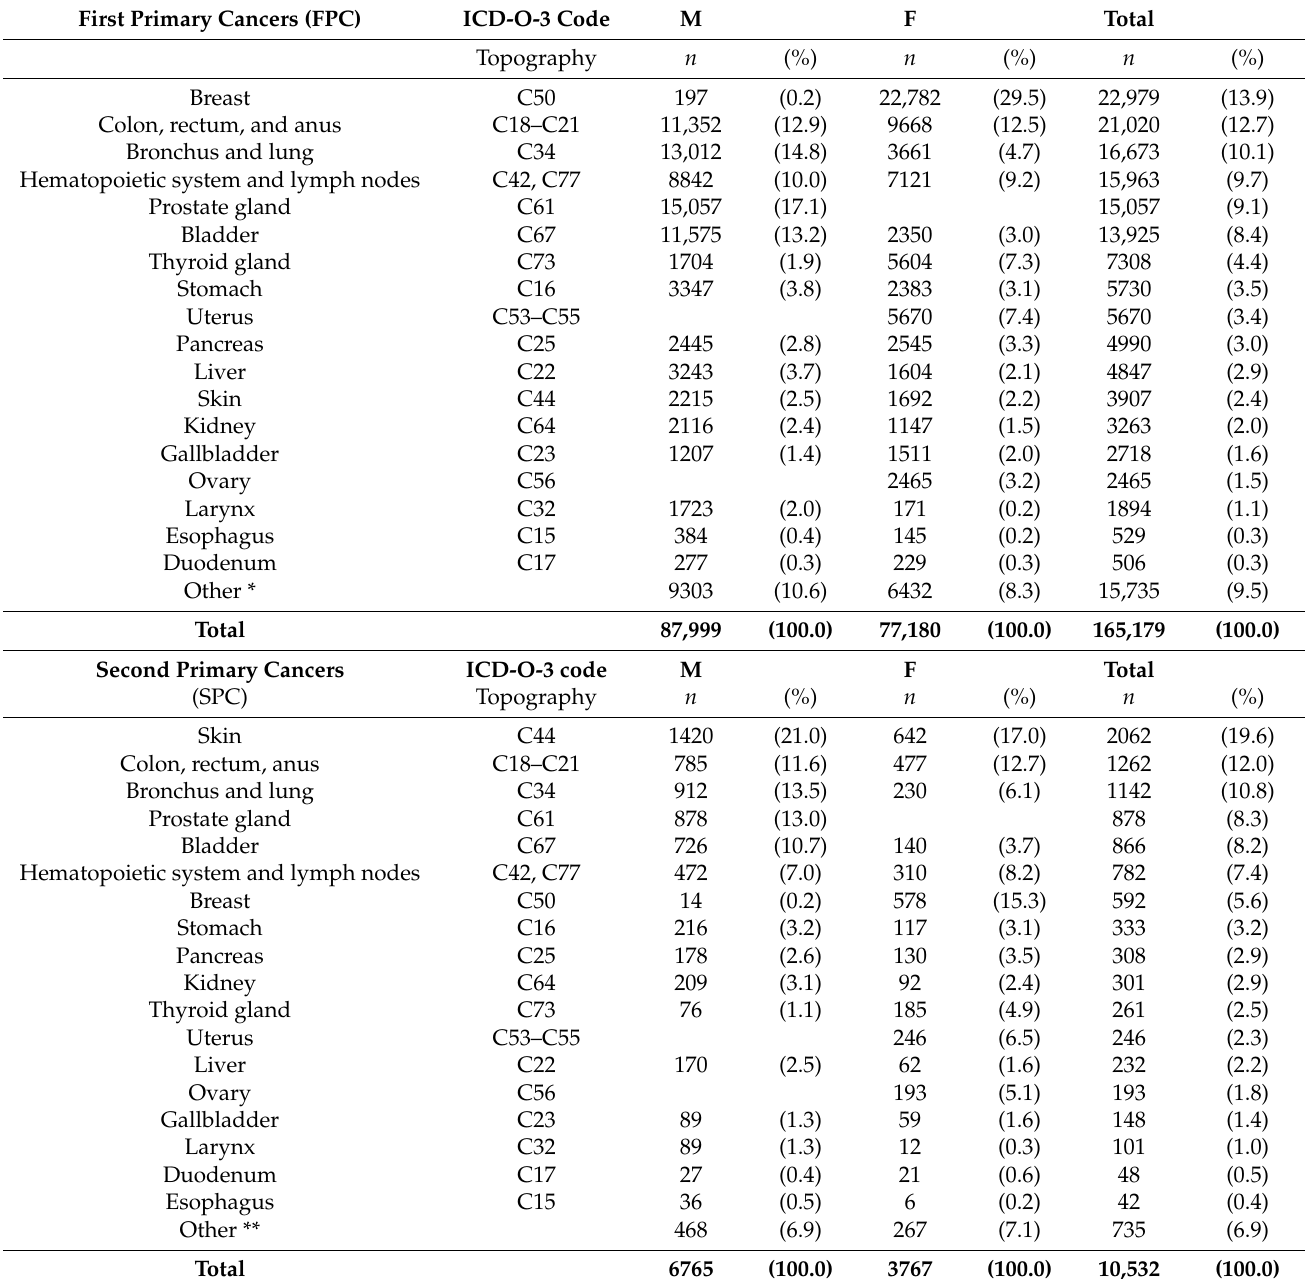
Table 1. Sites of first primary cancers (FPCs) and of second primary cancers (SPCs) according to decreasing total